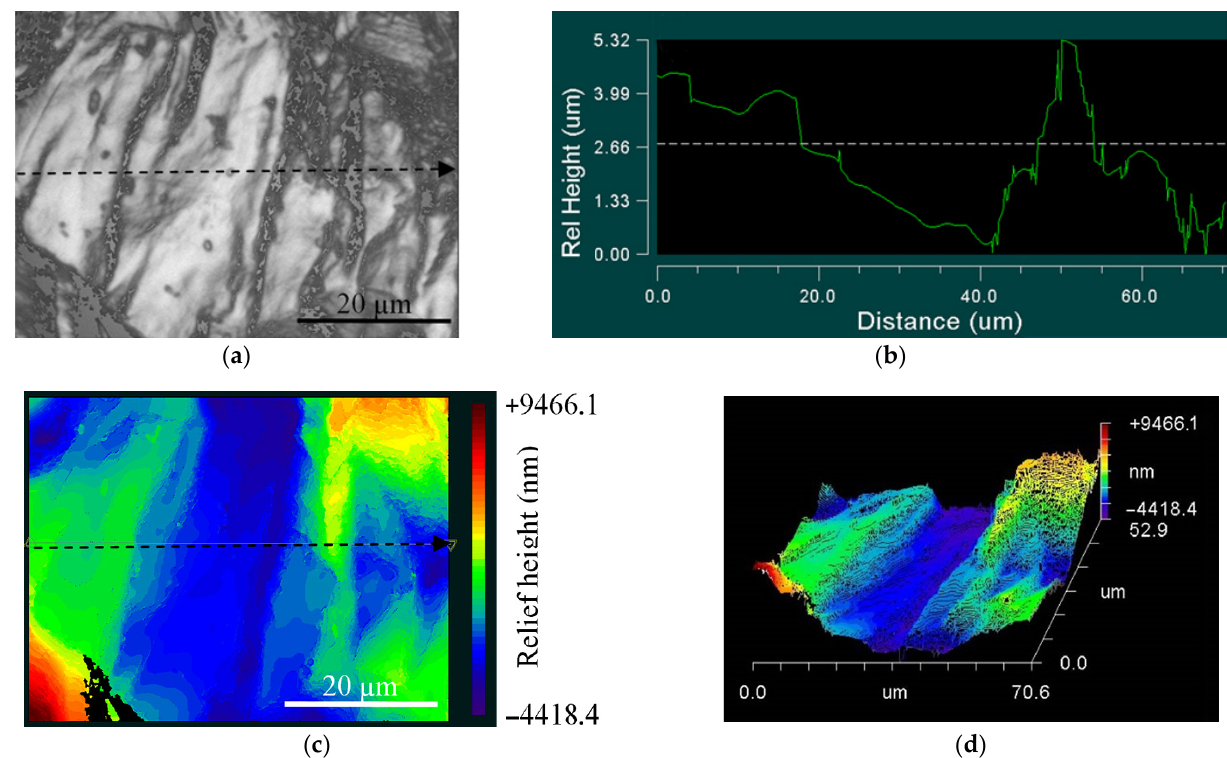
image of scanning area; ( b ) surface profile; ( c ) 2D-relief map; ( d ) 3D-relief map.